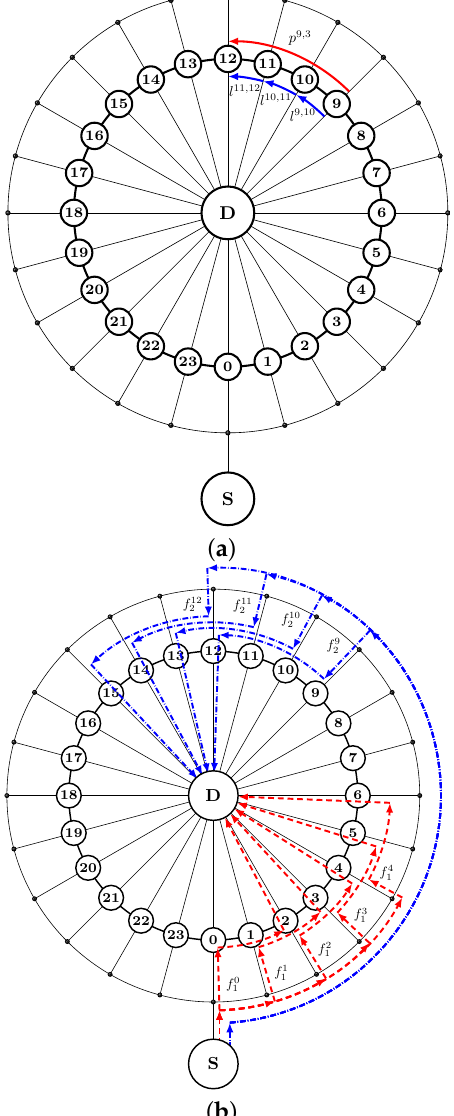
Figure 3. Atomic energy consumption scheduling based on optimal routing: ( a ) A network connecting the source ( S ) and the destination ( D ) through 24 intermediate nodes with a sample path ( p 9,3 ) and its constituent links ( l 9,10 , l 10,11 , and l 11,12 ) and ( b ) mapping of all possible atomic operations of two appliances into two groups of flows ( f 0 , . . . , f 4 and f 9 , . . . , f 12 ) over multiple paths on the 2 2 1 1